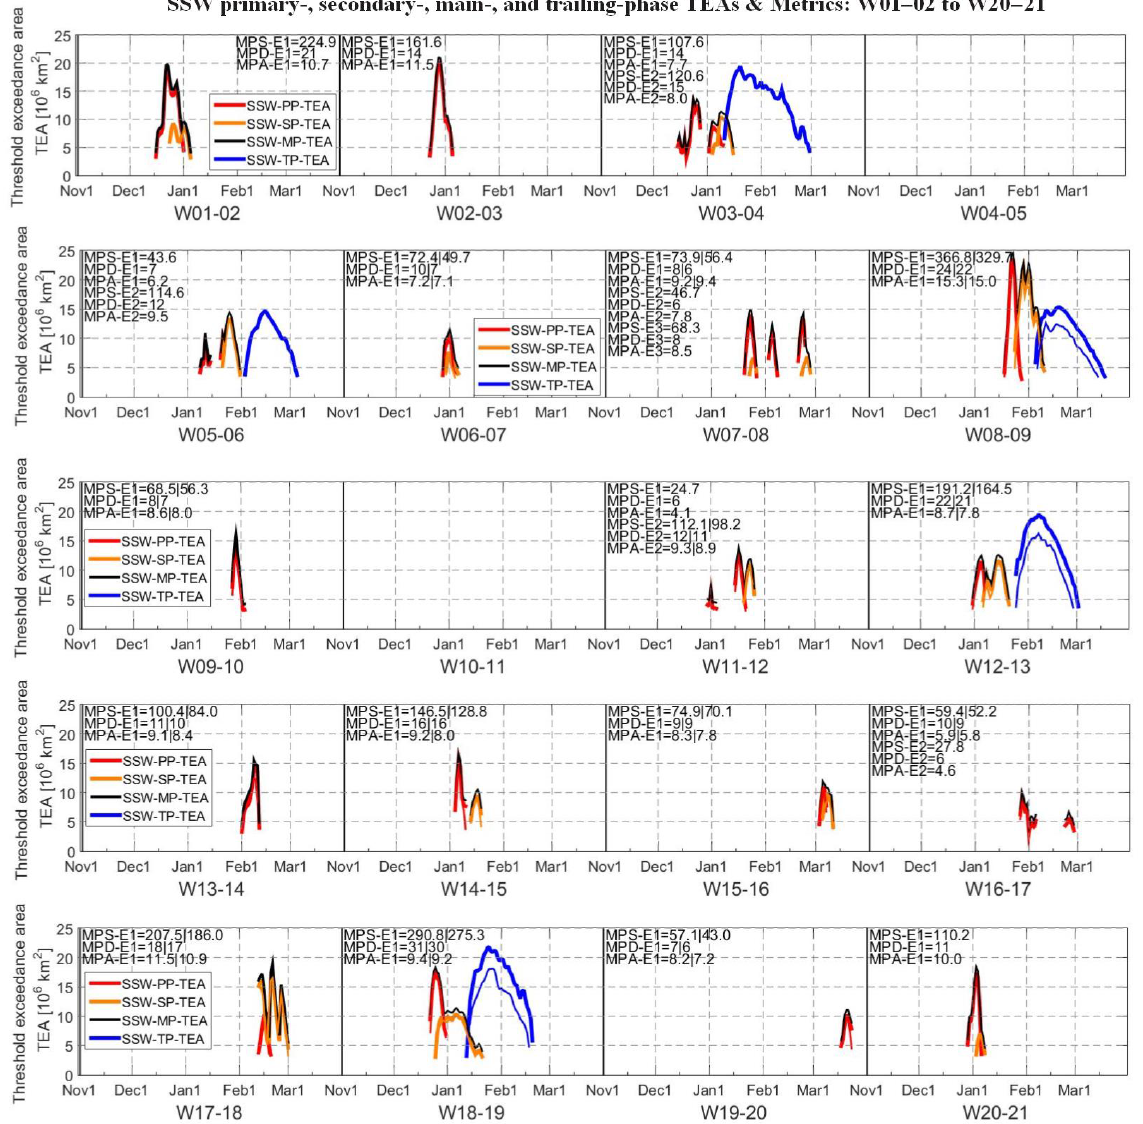
Figure 8. Time evolution of the SSW TEAs (SSW-PP-TEA, SSW-SP-TEA, SSW-MP-TEA, SSW-TP-TEA as applicable; for definitions, see Table 1) for all recorded SSW events of the winters W01–02 to W20–21; the SSW metrics MPS, MPD, and MPA (for definitions and units, see Table 2) are noted in the panels (E1, E2, and E3 are SSW event numbers, ordered according to the occurrence time in a winter). ERA5 results (heavy lines) are complemented by RO results (light lines, especially visible for stronger events) for the winters W06–07 to W19–20.